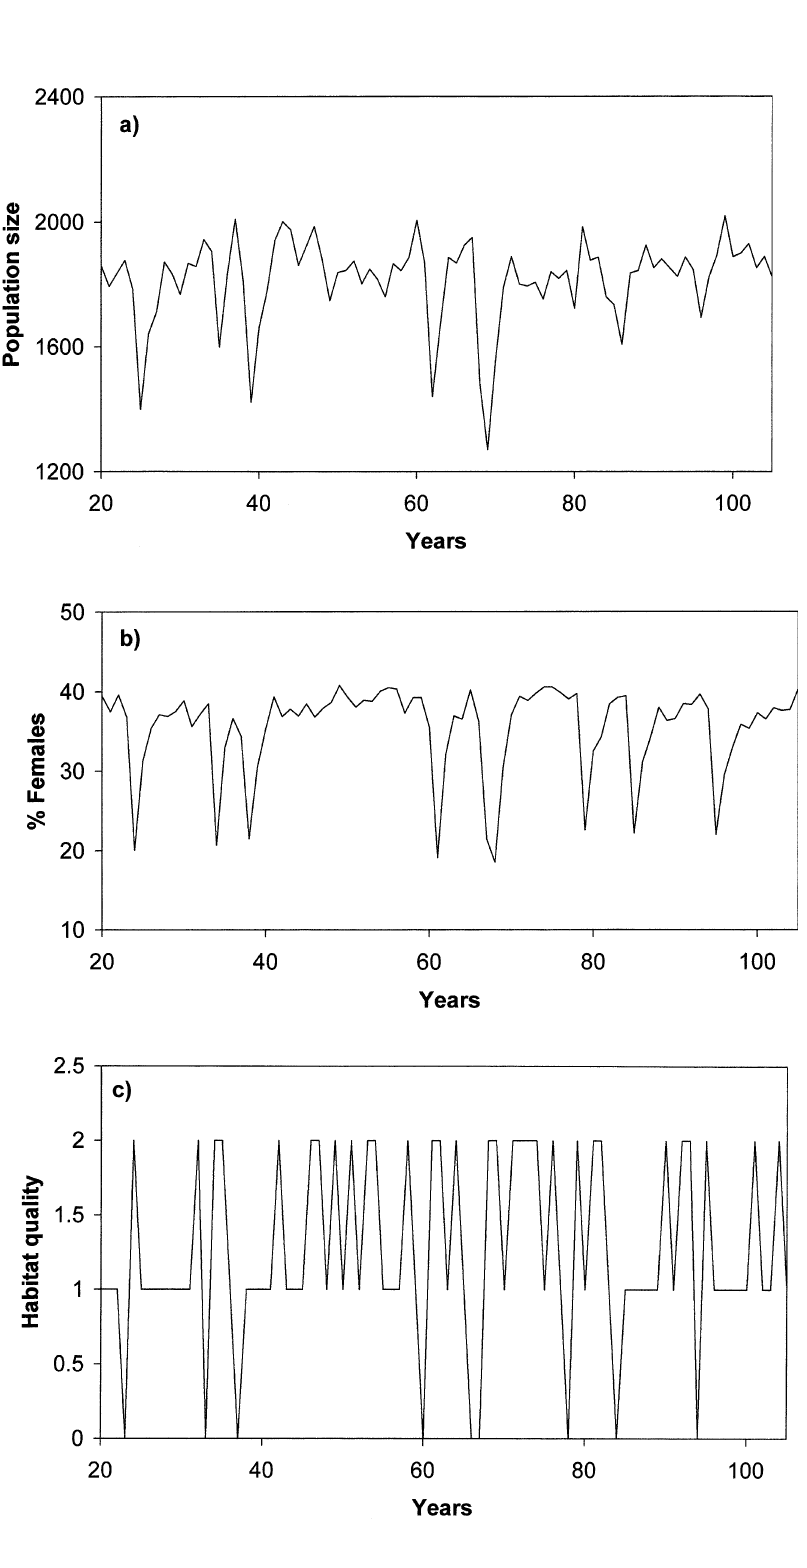
Fig. 4. Development of a solitary bee population in a heterogeneous environment a) population size; b) sex ratio; c) level of habitat